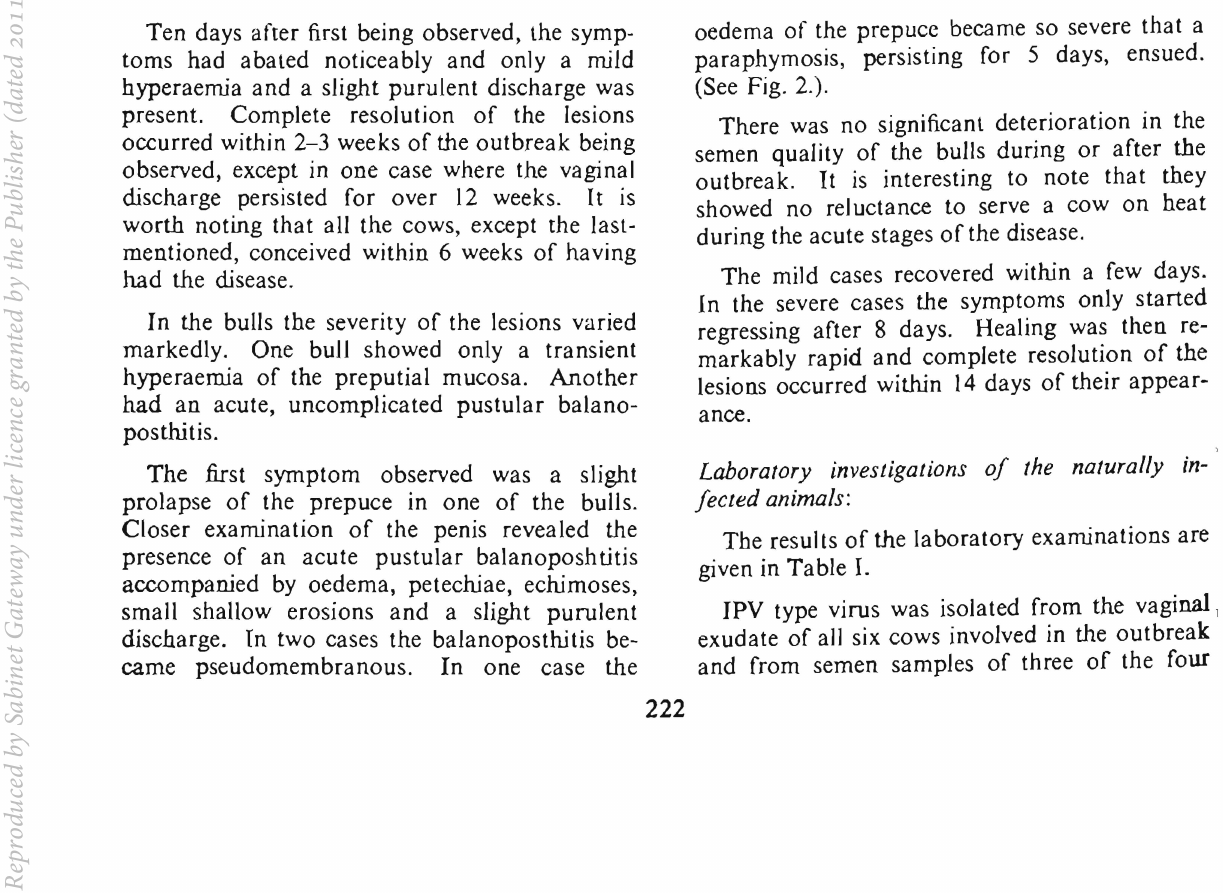
Figure I. Posterior vagina of naturally infected cow showing typical